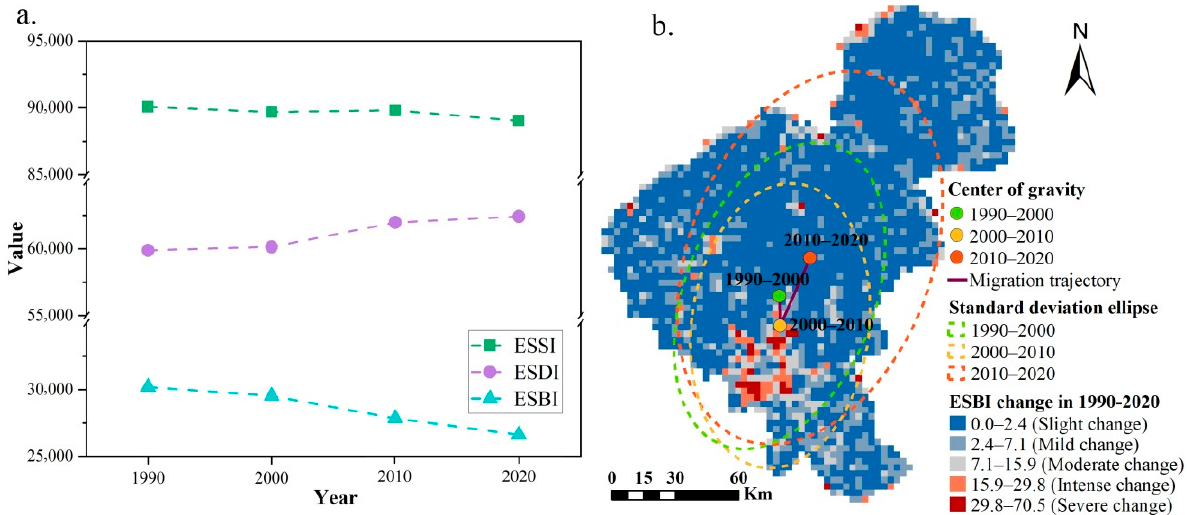
Figure 4. Overall trends of the ESSI, ESDI, and ESBI ( a ) and spatial migration map of the absolute ESBI changes ( b ) from 1990 to 2020.